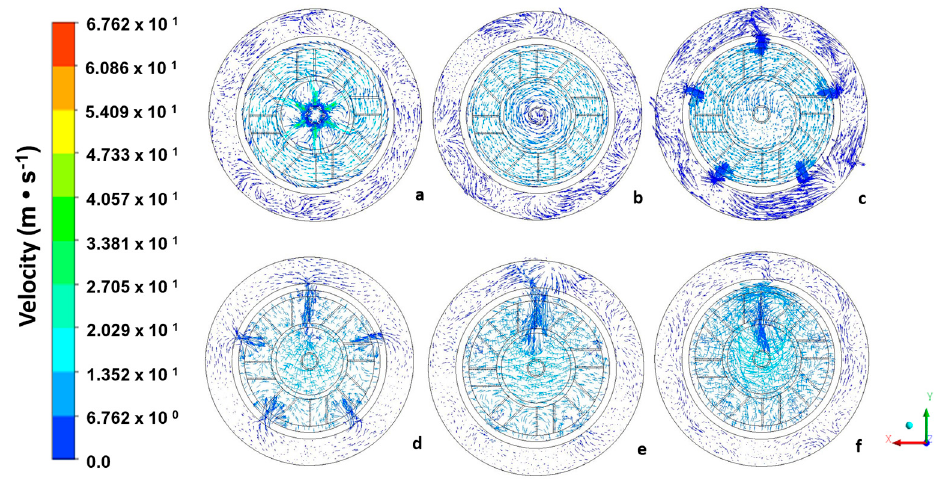
Figure 7. Combustion velocity profiles at transverse planes: ( a ) plane 1; ( b ) plane 2; ( c ) plane 3; ( d ) plane 4; ( e ) plane 5; ( f ) plane 6.